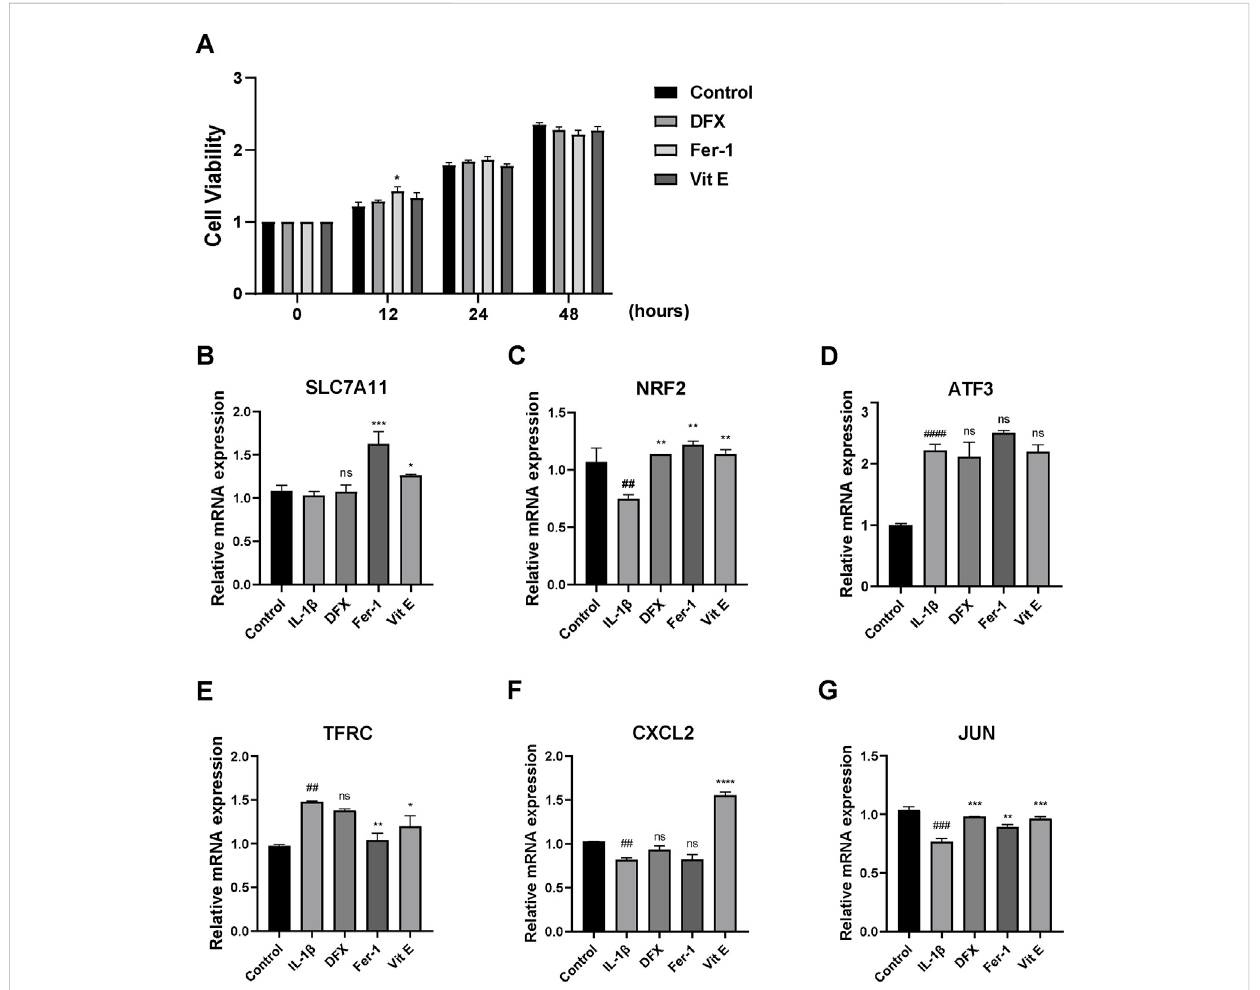
FIGURE 6 (A) CCK8analysisresultsofcellviabilityofchondrocytesreceivingIL-1 β alone,IL-1 β +deferasirox,IL-1 β +ferrostatin-1andIL-1 β +vitamin (E) . (B – C) Quantitative real-time PCR analyses of SLC7A11 and NRF2. (D – G) Quantitative real-time PCR analyses of ATF3, TFRC, CXCL2 and JUN in the control group and chondrocytes receiving IL-1 β alone,IL-1 β + deferasirox, IL-1 β +ferrostatin-1 and IL-1 β + vitamin E. DFX: deferasirox; Fer-1: ferrostatin-1; VitE: vitaminE;ns:notsigni fi cantcomparedtoIL-1 β treatmentgroup; ## signi fi cantcomparedtothecontrolgroup, p < 0.01; ### signi fi cantcomparedto the control group, p < 0.001; #### signi fi cant compared to the control group, p < 0.0001; * p < 0.05 compared to IL-1 β treatment group; ** p